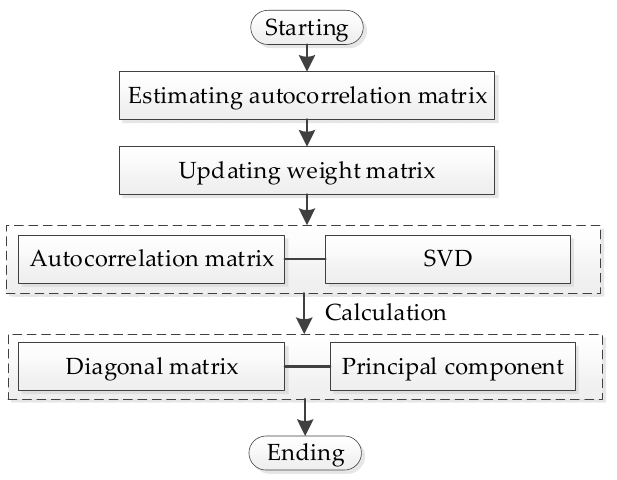
Figure 2. The implementation process of FMPCE.